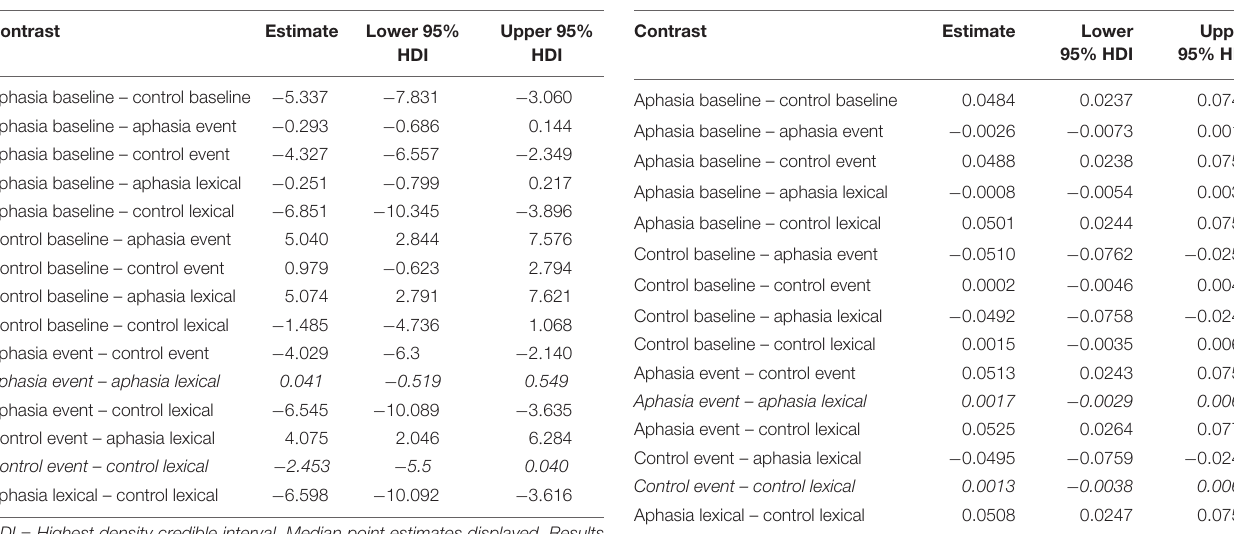
TABLE 5 | Model 1 naming accuracy pairwise comparisons.